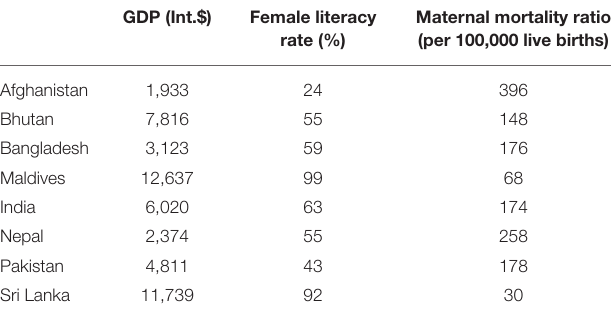
TABLE 1 | Gross domestic product (GDP; international dollars), female literacy rate (%), and maternal mortality ratio (MMR; per 100,000 live births) for South Asian countries, 2015 [Source (1) World Bank (1, 36), (2) United Nations (18), and (3) UNESCO Institute for Statistics ( 22)]. GDP (Int.$) Female literacy Maternal mortality ratio rate (%) (per 100,000 live